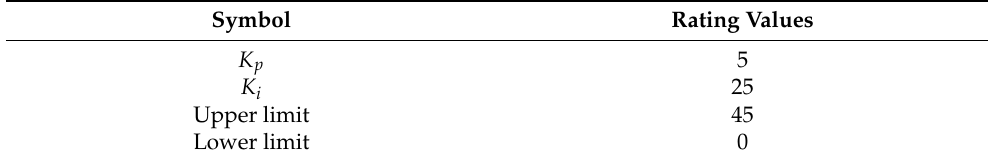
Table A4 displays the adjustment settings for modifying the pitch. Table A4. Adjustment settings for modifying the